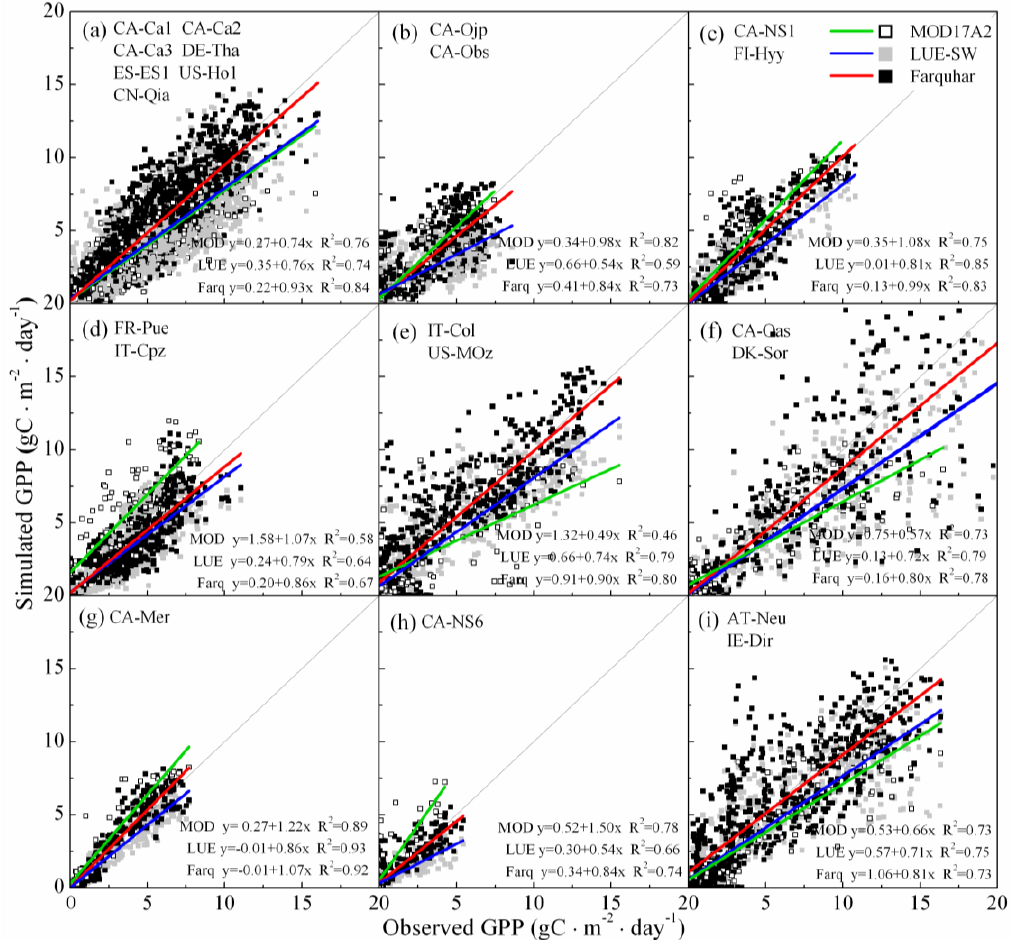
Figure 2. Comparisons of the observed GPP and the MOD17A2: the GPP simulated by the LUE-SW and by the Farquhar model for different plant functional types: ( a , b ) needleleaf evergreen forests in temperate and boreal zones; ( c ) needleleaf deciduous forests in boreal zone; ( d ) broadleaf evergreen forests in temperate zone; ( e , f ) broadleaf deciduous forests in temperate and boreal zones; ( g , h ) broadleaf deciduous shrubs in temperate and boreal zones; and ( i )